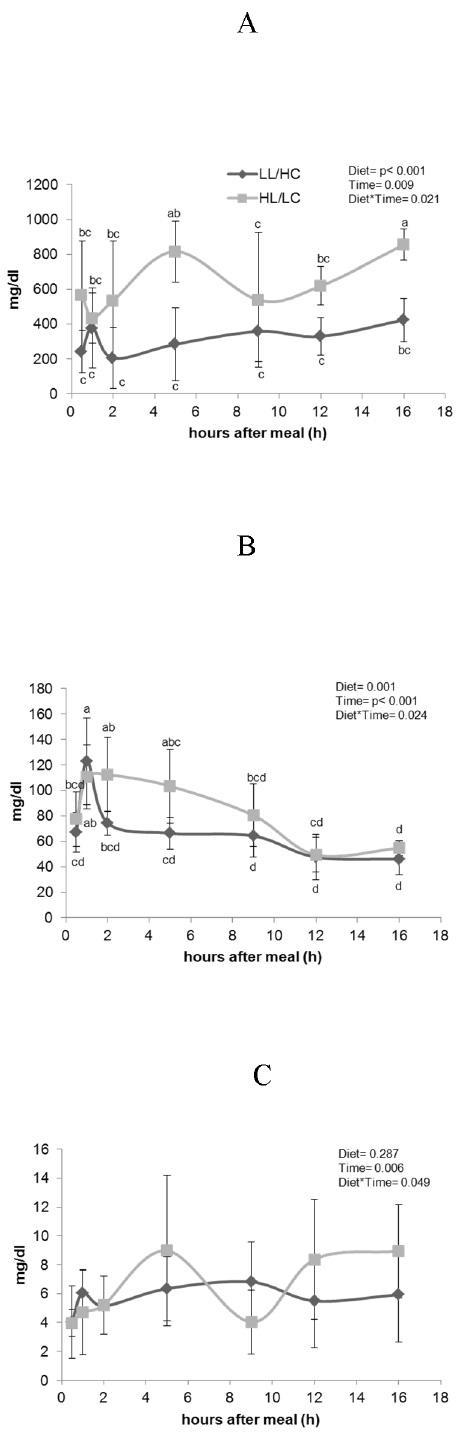
Figure 1. Postprandial plasma triglycerides (A), glucose (B) and lactate (C) of fish fed LL/HC or HL/LC diet (n=9). Data were submitted to a two way ANOVA.